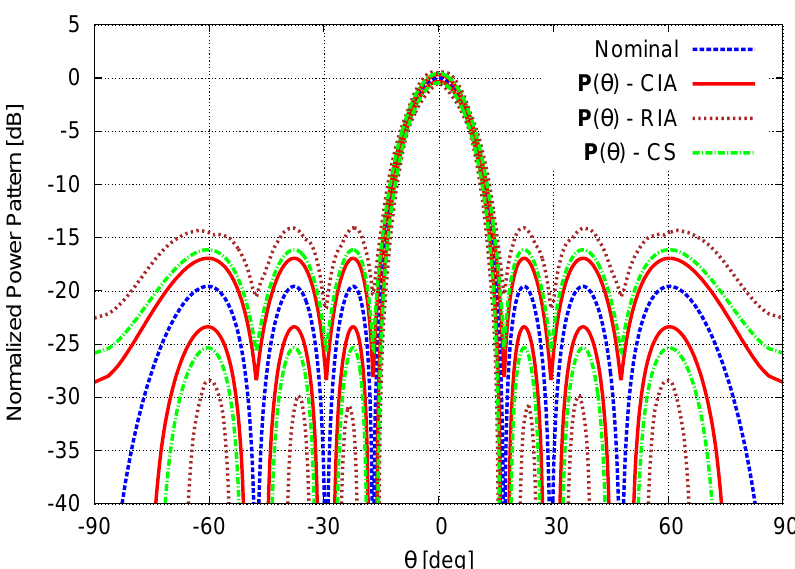
Figure 3. Calibration Error ( N = 8, d = λ ; Dolph–Chebyshev pattern: SLL ref = − 20 dB)—Nominal 2 power pattern and interval power pattern bounds predicted by the the circular IA (CIA), the rectangular IA (RIA), and the Cauchy-Schwartz-based method (CS) [16].